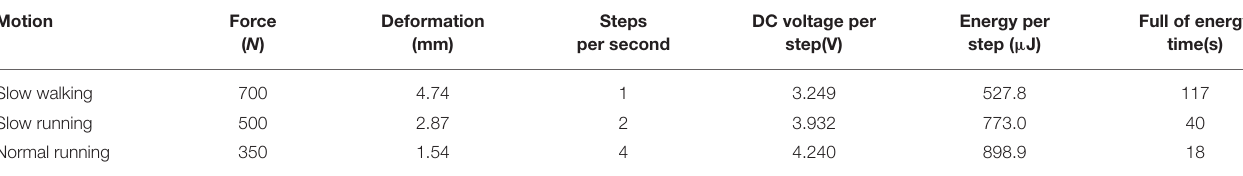
TABLE 3 | Different motion energy harvesting.